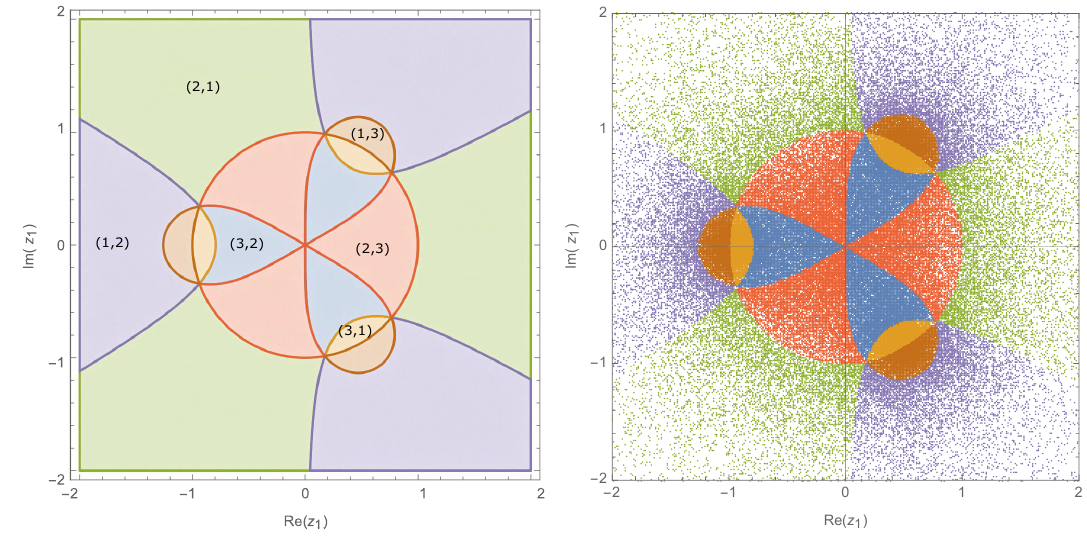
Figure 4 . The torus can be viewed as three Riemann sheets glued together through branch cuts stretching between the cubic roots of − 1 and the point at infinity. Three copies of the complex plane span the chart (3 , 2) . The different regions in color correspond to the intersection with other patches. In the plot on the right, we present the distribution of sample points following the method indicated in section